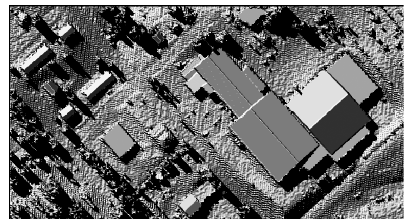
Figure 9. The result of raw LiDAR data interpolation by our software.